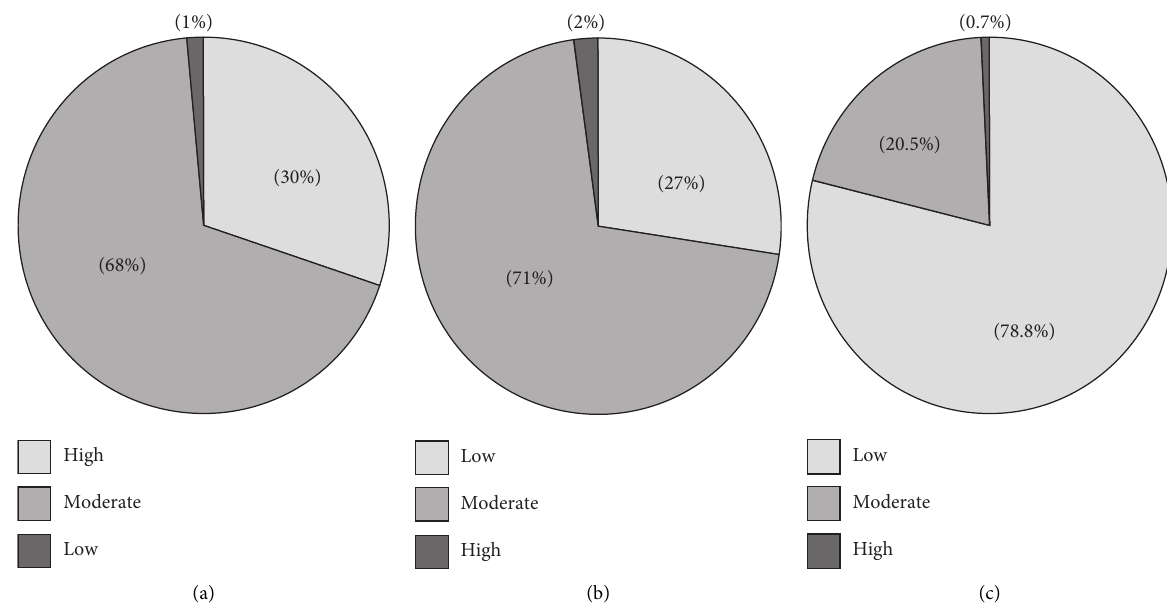
Figure 6: Sensorial characteristics of fresh fruits from 146 FFNC ecotypes. (a) Sweet. (b) Acid. (c) Bitter.